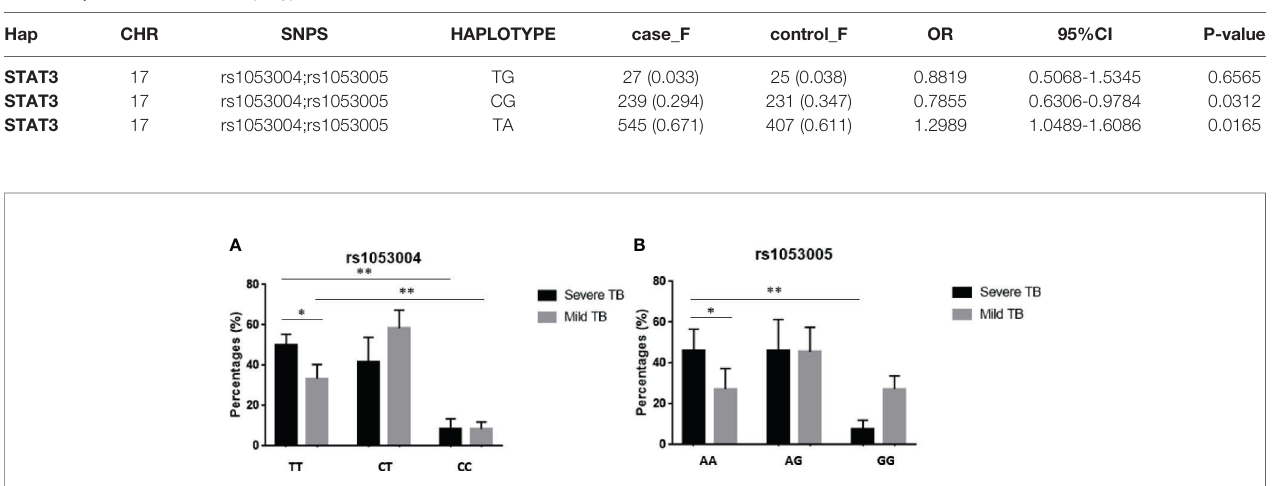
FIGURE 1 | The percentages of subjects with different genotypes in TB patients. The bars showed the percentages of subjects with genotypes TT, CT and CC of rs1053004 (A) , and with AA, AG and GG of rs1053005 (B) in mild TB and severe TB, respectively. Data from 110 mild TB patients and 130 severe TB patients. *P < 0.05 and **P <